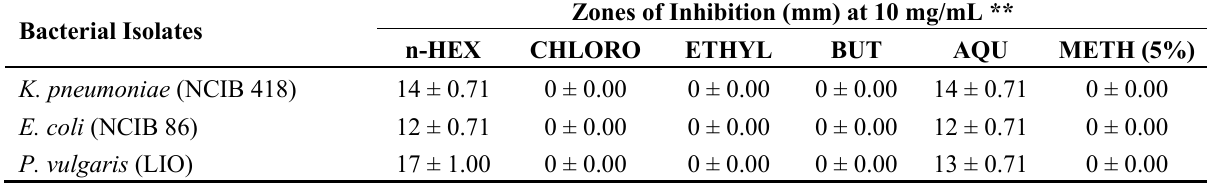
Key: LIO = Locally Isolated Organism, NCIB = National Collection of Industrial Bacteriology, N-HEX = n -hexane fraction, CHLORO = Chloroform fraction, ETHYL = Ethyl acetate fraction, BUT = Butanol fraction, AQU = Aqueous fraction, METH = 5% methanol as control, (mm) ** = Mean of five replicates.